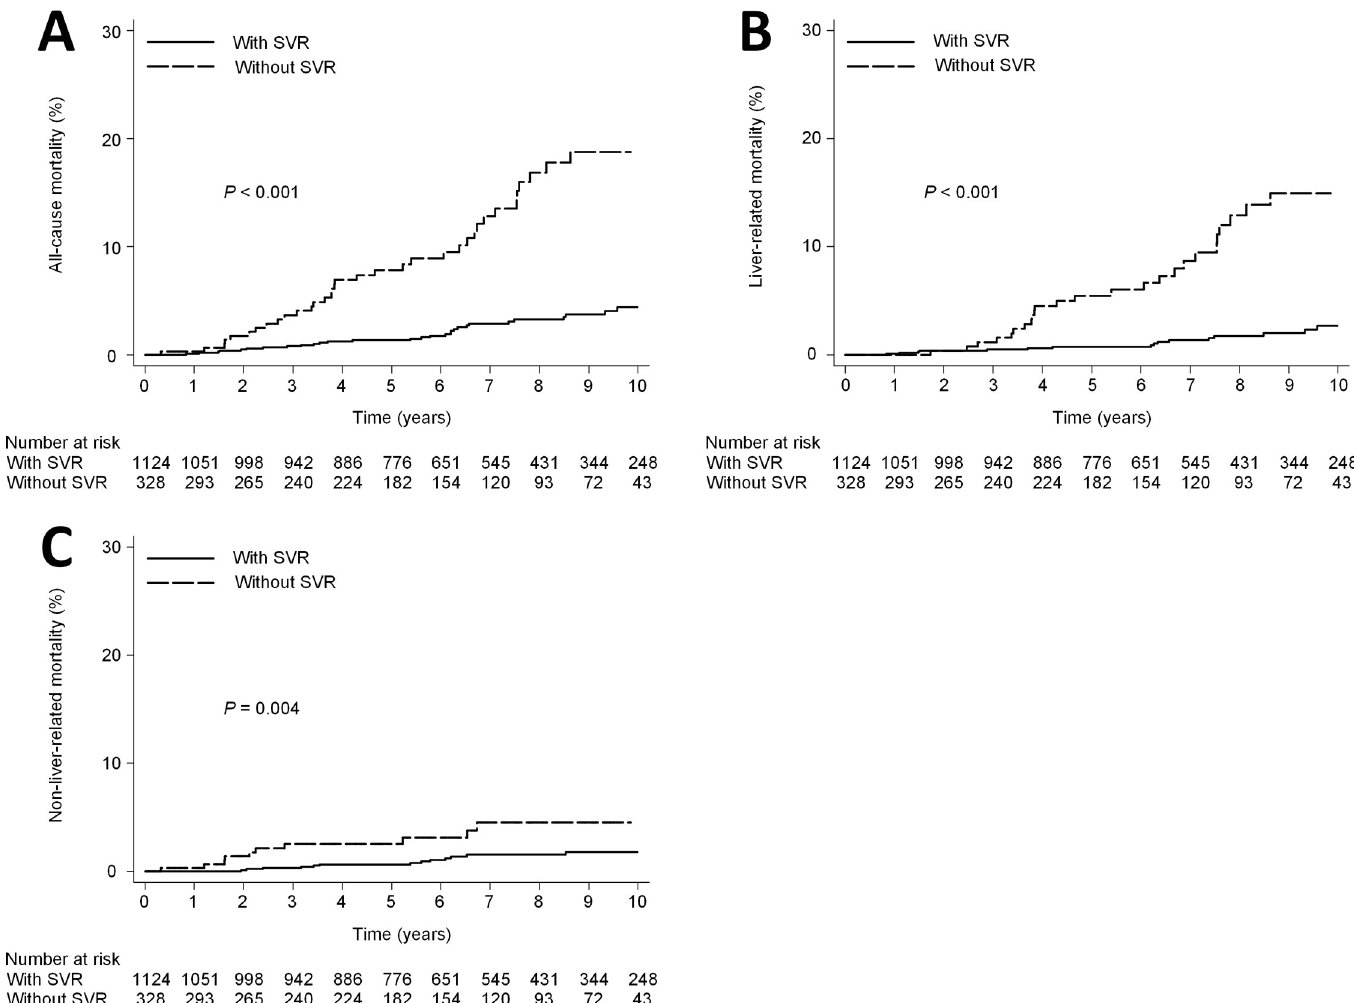
Fig 2. Mortality according to SVR in all patients. (A) all-cause mortality (10- year mortality rate, 4.4% vs 18.8%; HR, 0.21; 95% CI, 0.13–0.33; P < 0.001). (B) liver-related mortality (10- year mortality rate, 2.7% vs 15.0%; HR, 0.16; 95% CI, 0.09–0.29; P < 0.001). (C) non-liver-related mortality (10- year mortality rate, 1.8% vs 4.5%; HR, 0.31; 95% CI, 0.14–0.69; P =